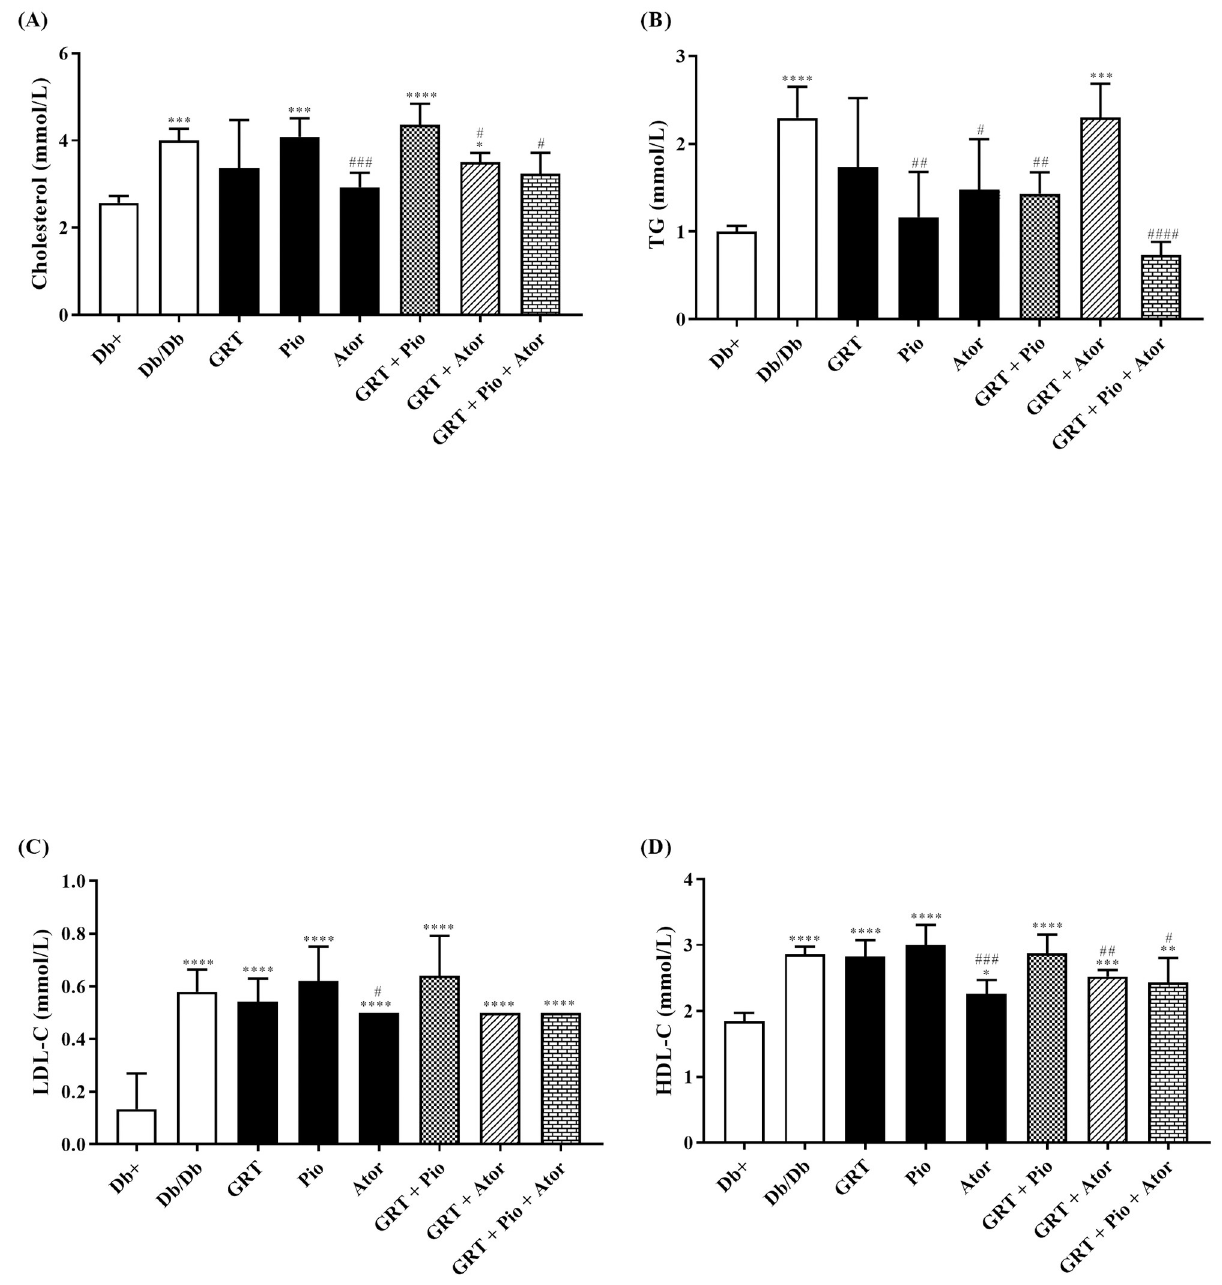
Fig 2. The effect of GRT (100 mg/kg BW), Pio (25 mg/kg BW), and Ator (80 mg/kg BW) mono- and co-therapies on changes in serum lipid contents. Serum lipid contents of (a) cholesterol, (b) TG, (c) LDL-C, and (d) HDL-C were measured after 5 weeks of treatment. Results are expressed as the mean ± SEM. � p < 0.05, �� p < 0.01 and ���� p < 0.0001 vs db+ ; # p < 0.05, ## p < 0.01 and ### p < 0.0001 vs db/db (One-Way ANOVA followed by Dunnett/Bonferroni multiple comparison test). TG, triglyceride; LDL-C, low density lipoprotein cholesterol and HDL-C, high density lipoprotein cholesterol; GRT, green rooibos extract; Pio, pioglitazone; and Ator,